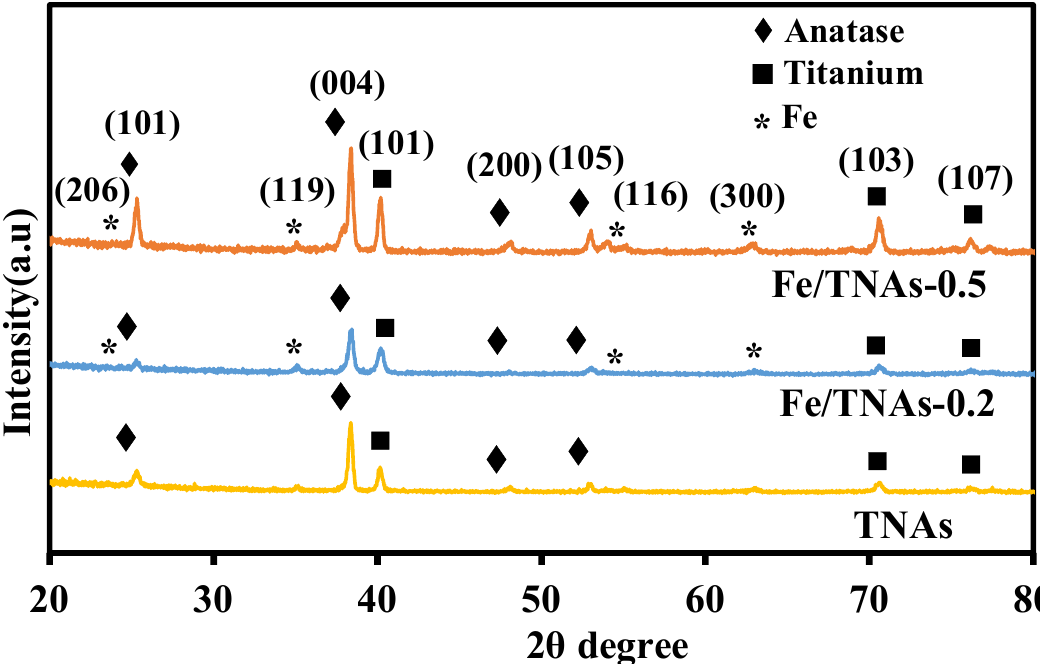
Figure 2. The XRD patterns for TNAs, Fe/TNAs-0.2, and